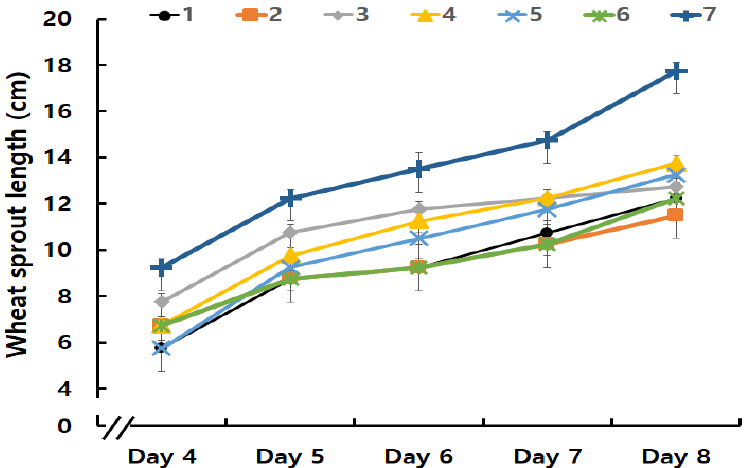
Figure 1. Effects of wheat variety on sprout length. (1) ‘Heuk1’. (2) ‘Australian standard white’. (3) ‘BaekJoong’. (4) ‘Baekkang’. (5) ‘Saekeumkang’. (6) ‘Jeonju391’. (7) ‘Ariheuk’ (purple wheat).